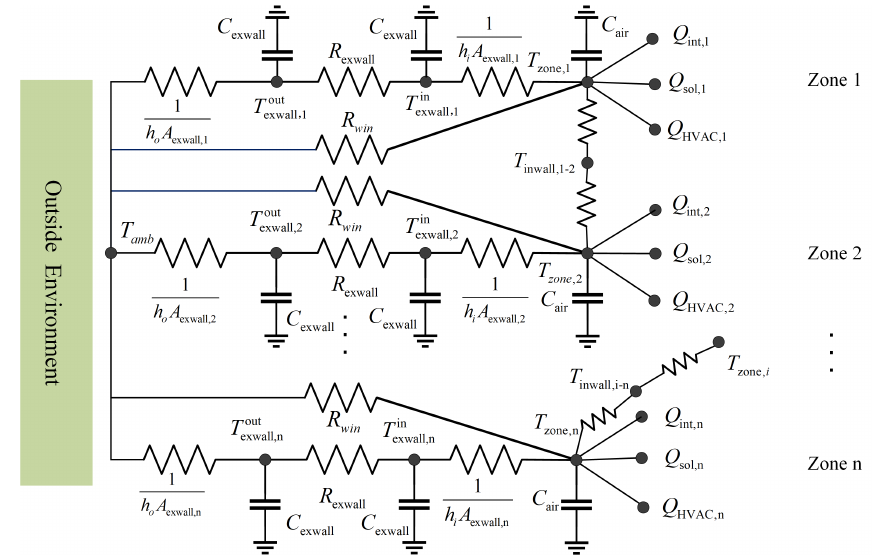
Figure 1. Schematic representation of multi-zone 3R-2C building